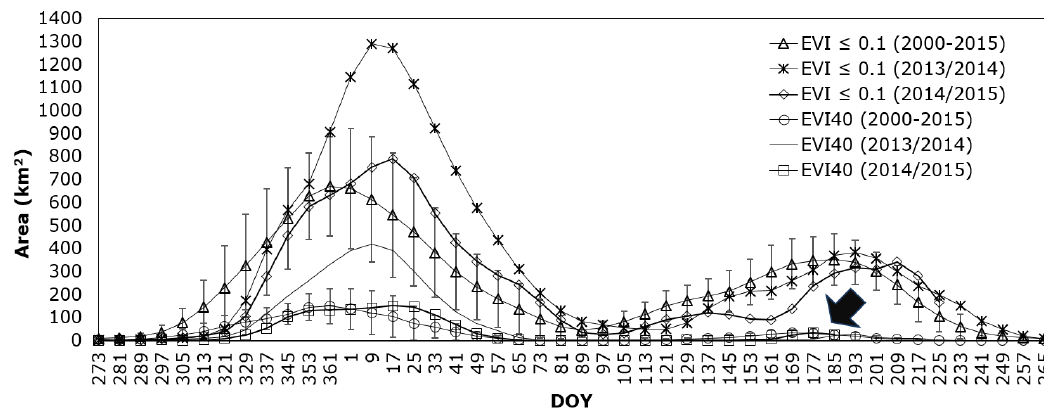
Figure 7. Time series of total areas (km 2 ) of rice fields with surface water and flooding derived from EVI ≤ 0.1 and EVI40 respectively in 2013/2014, 2014/2015, and long-term average (2000–2015). Black arrow points to misclassified flood pixels (False Positive) detected using EVI40 during dry planting seasons 2014 and